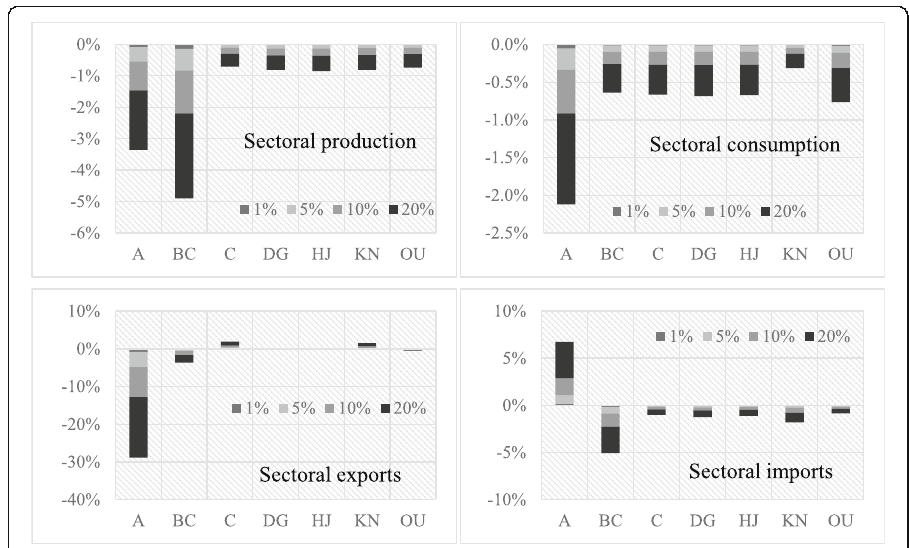
Fig. 11 Simulated sectoral effects of government revenue neutral tax on use of nitrogen fertilizer (product of chemical industry) in agricultural production (neutralization based on decrease of income tax). (Source: authors calculations based on CGE model simulations